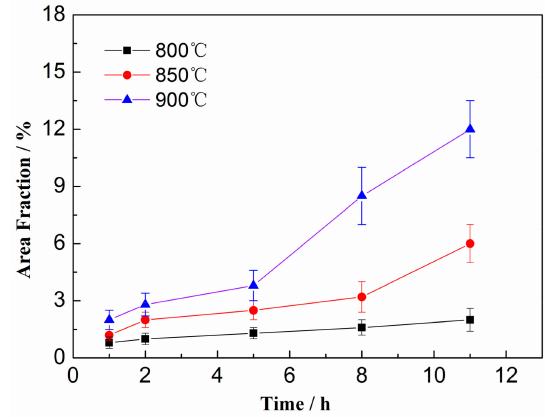
Figure 3. Area fractions of δ phase versus aging time at di ff erent selected